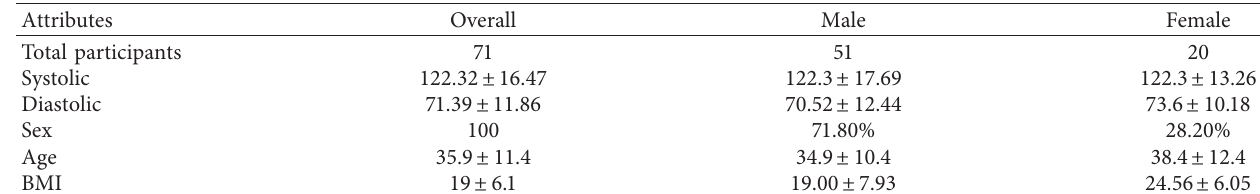
Figure 1: Lifestyle, dietary, and clinical blood markers differ between Assamese populations. (a) Map showing the three different sampling locations in Assam. Aanthmile (red) and Jagiroad (gold) are home to Nepali speakers who practice agropastoralism. Kamalabari, Majuli (blue), is home to the native Assamese known to practice traditional animal herding and meditation. (b) A heatmap showing differences in diet as well as blood phenotypes between these populations. (c) A principal component analysis (PCA) differentiates populations based on their diet and clinical blood markers. PC1 separates individuals by lifestyle/diet and body mass index (BMI). PC2 is associated with several risk factors for chronic diseases, including age, systolic blood pressure as well as disease conditions, e.g., diabetes and gastric condition (presence or absence of gastritis) that do not differ between the two lifestyles. Table 1: Systolic and diastolic blood pressure in male vs.